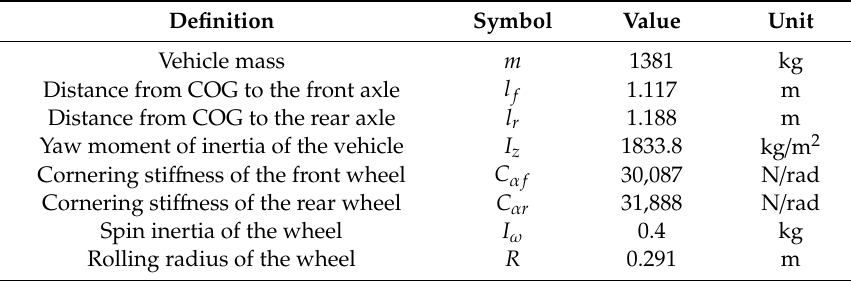
Table 1. Main parameters of the autonomous vehicle.